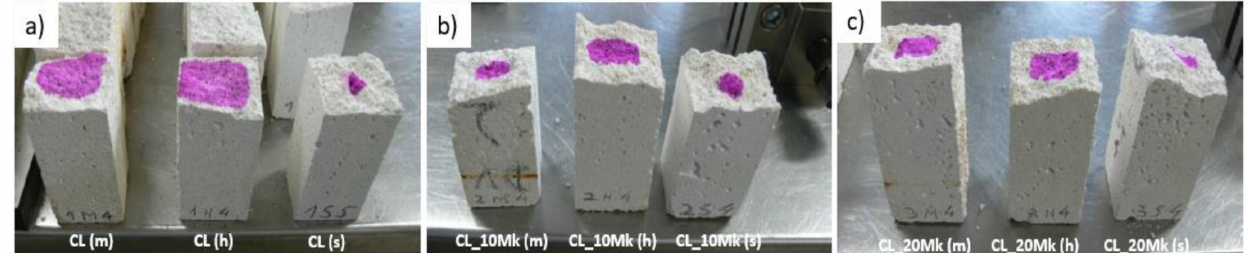
Figure 6. Carbonation at 90 days of curing in maritime, saturation and standard conditions: ( a ) reference mortars CL (m), CL (h) and CL (s); ( b ) mortars CL_10Mk (m), CL_10Mk (h) and CL_10Mk (s); ( c ) mortars CL_20Mk (m), CL_20Mk (h) and CL_20Mk